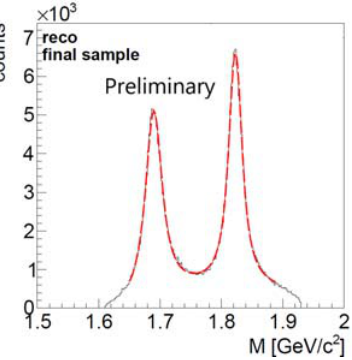
Figure 7. Mass distribution of the final selected Λ K − candidates.